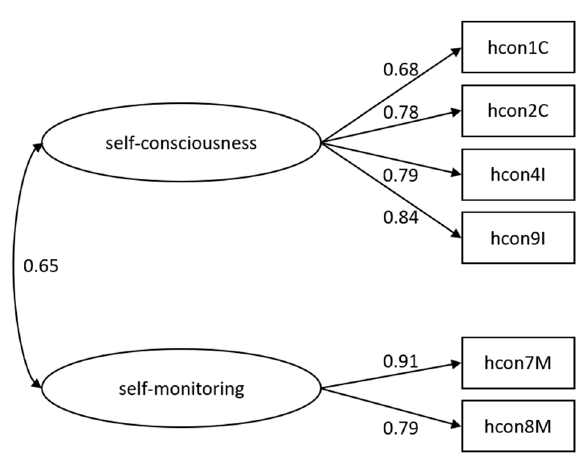
Figure 1. Two ‐ factor (short) model of health consciousness. Square boxes represent items. Circles represent factors. Unidirectional arrows indicate factor loadings. Bidirectional arrow indicates inter ‐ factor correlation.